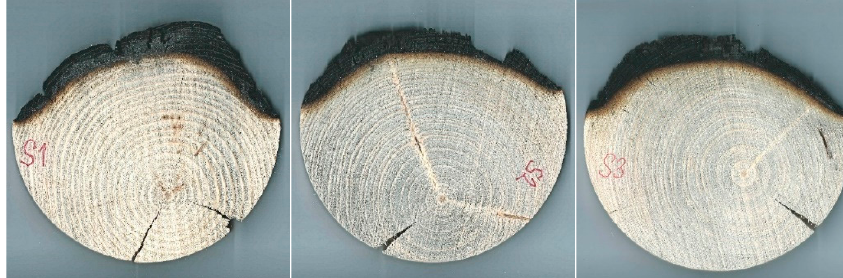
Figure 12. Sample slices—Norway spruce logs.